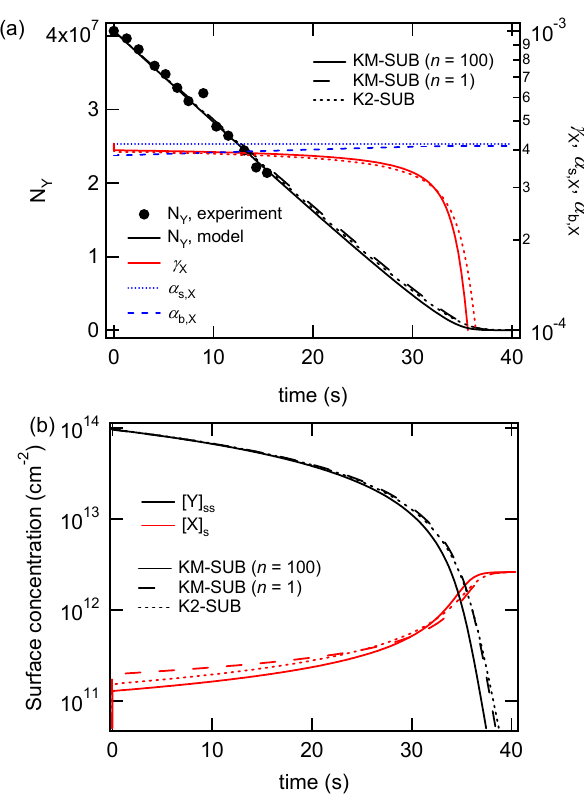
Fig. 2. Temporal evolution of model base case 1 in KM-SUB with n = 1 (dashed lines) and n = 100 (solid lines) and in K2-SUB (dot- ted lines). (a) Experimental data (black symbols; Ziemann, 2005) and model results for the total number of oleic acid molecules ( N Y , black line) and for the uptake coefficient of ozone ( γ X surface accommodation coefficient ( α s , X , blue dotted line), and bulk accommodation coefficient ( α b , X , blue dashed line). (b) Sur- face concentrations of oleic acid (black line) and ozone (red